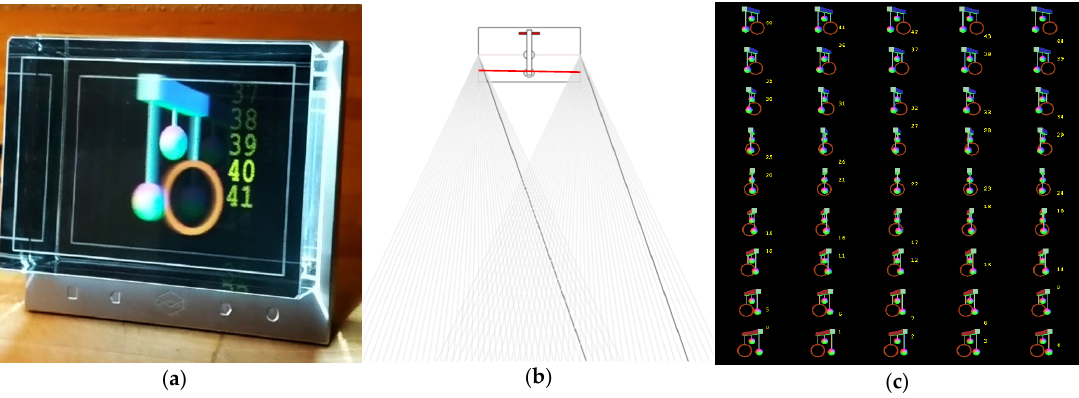
Figure 1. Diagrams demonstrating how the TLG display works: ( a ) is an image that shows what is viewed on the TLG display at different positions. The numbers in the scene showcase the different views/perspective of the scene as the viewer moves from one edge to the other [22]. ( b ) is a top-down ray diagram of the parallax used to create the 3D visualization at different positions. The bold lines show the eye positions needed to see the viewpoint shown in ( a ) [22]. It also shows the zero-parallax plane (the thin red line) where objects are the sharpest in the scene. ( c ) is known as the ‘quilt’, which displays the 45 views simultaneously on TLG [22].